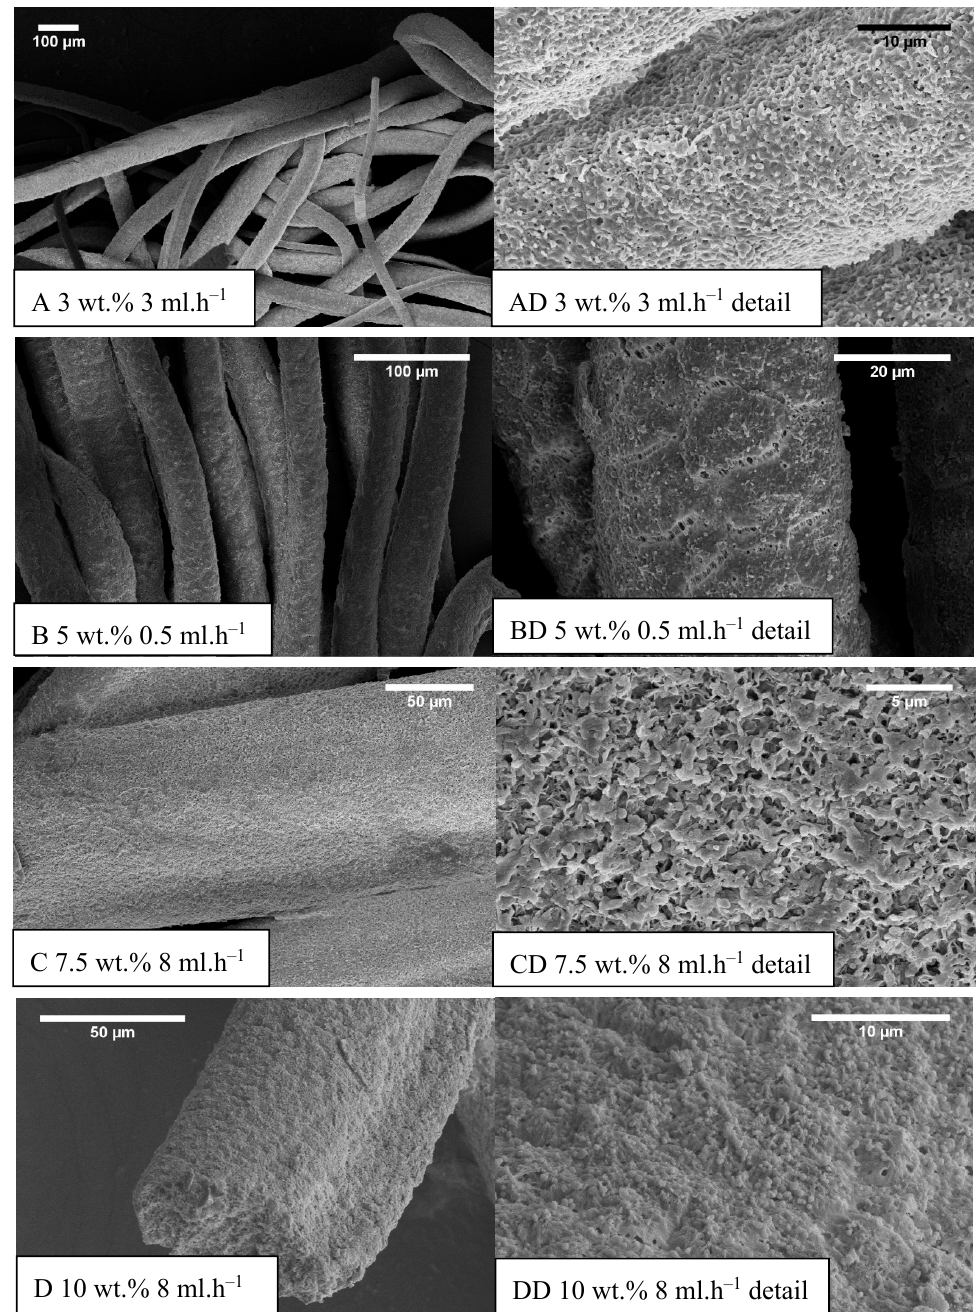
Figure 4. Example SEM images of prepared samples (concentration (wt.%) feed rate (ml.h − 1 )), ( A–D ) the standard magnitude with an overall picture of fibers, ( AD–DD ) detailed